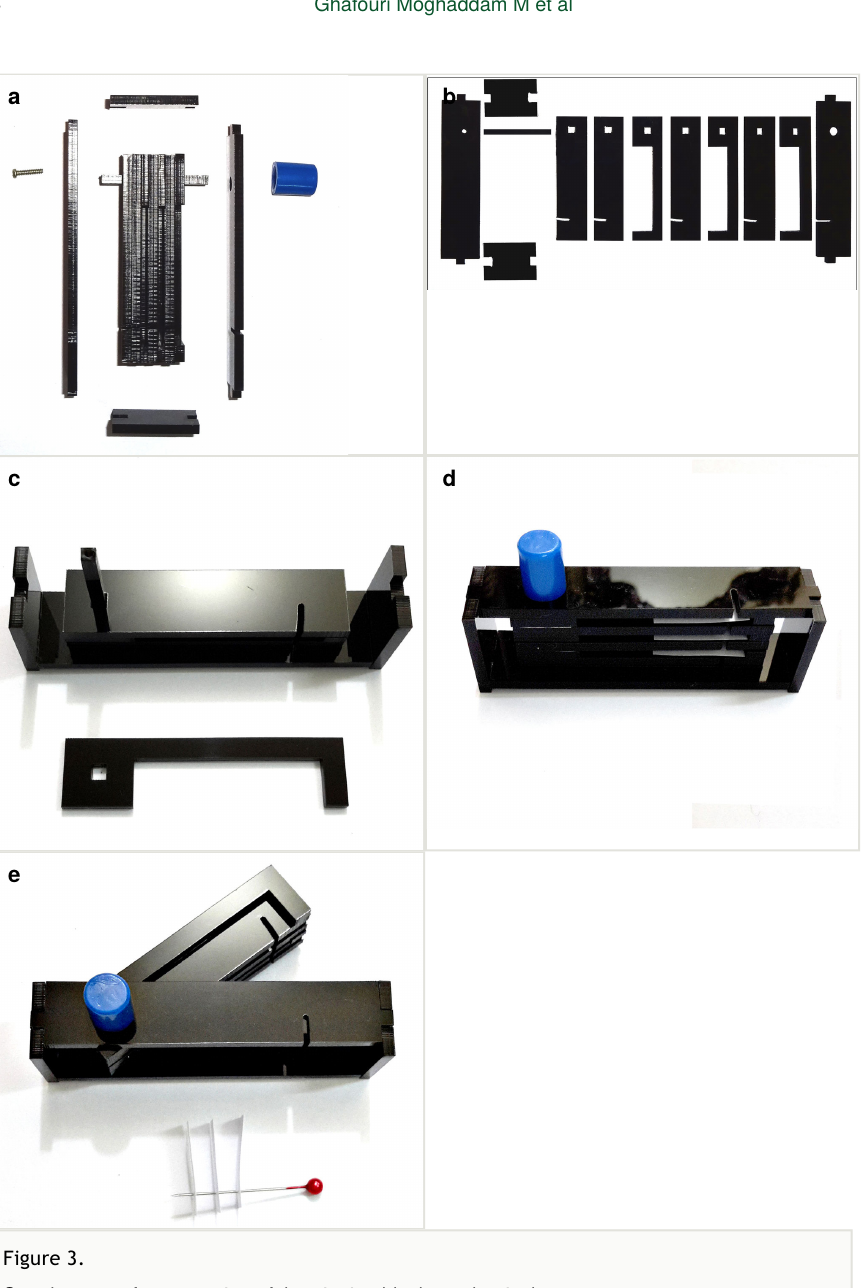
Step-by-step of construction of the pinning block